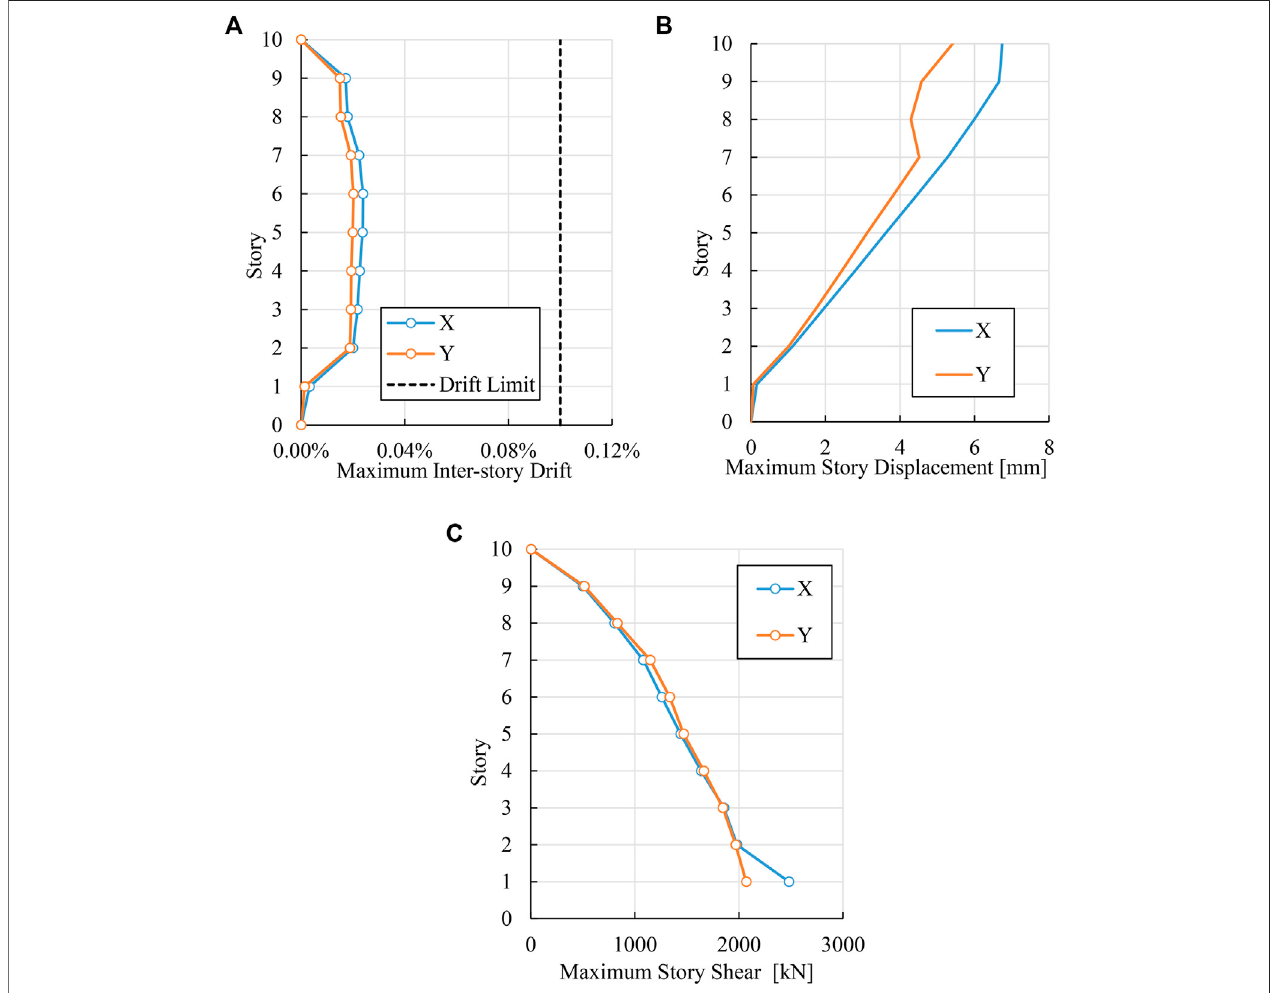
FIGURE 12 | Seismic Response, (A) maximum inter-story drift; (B) maximum story displacement; (C) maximum story shear.